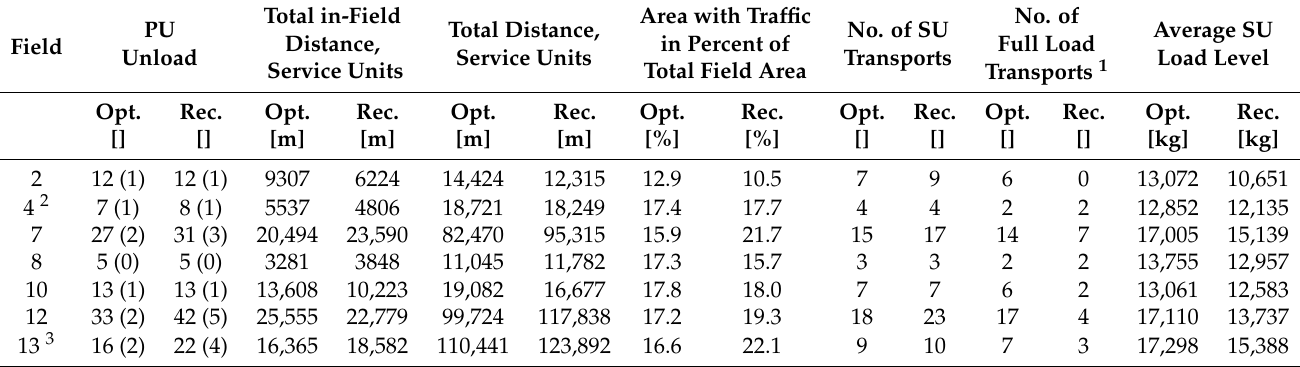
Table 2. Comparison of the recorded (Rec.) and optimised (Opt.) number of PU unloadings, the travelled distance of SUs, the percentage of field area with traffic from SUs, the load level variation, and the number of loads per field.